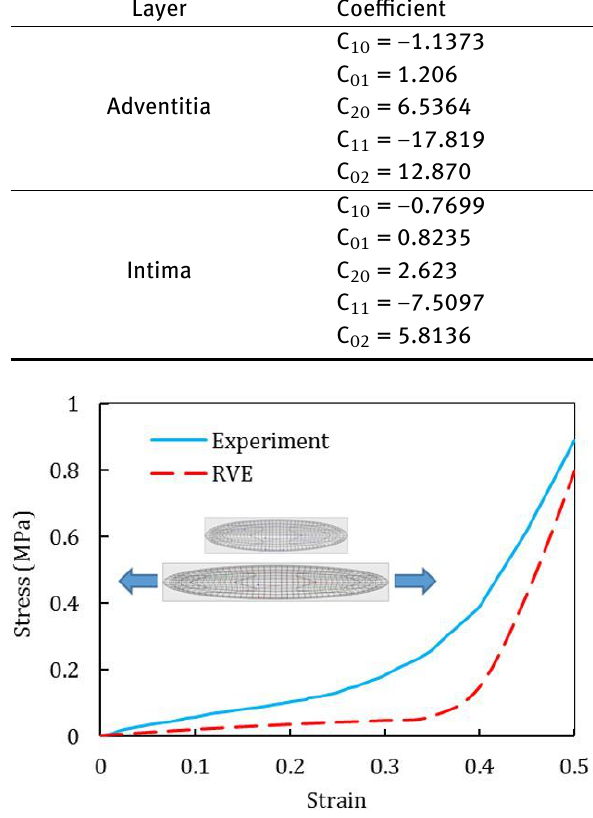
Figure 4: Stress-strain response of the media